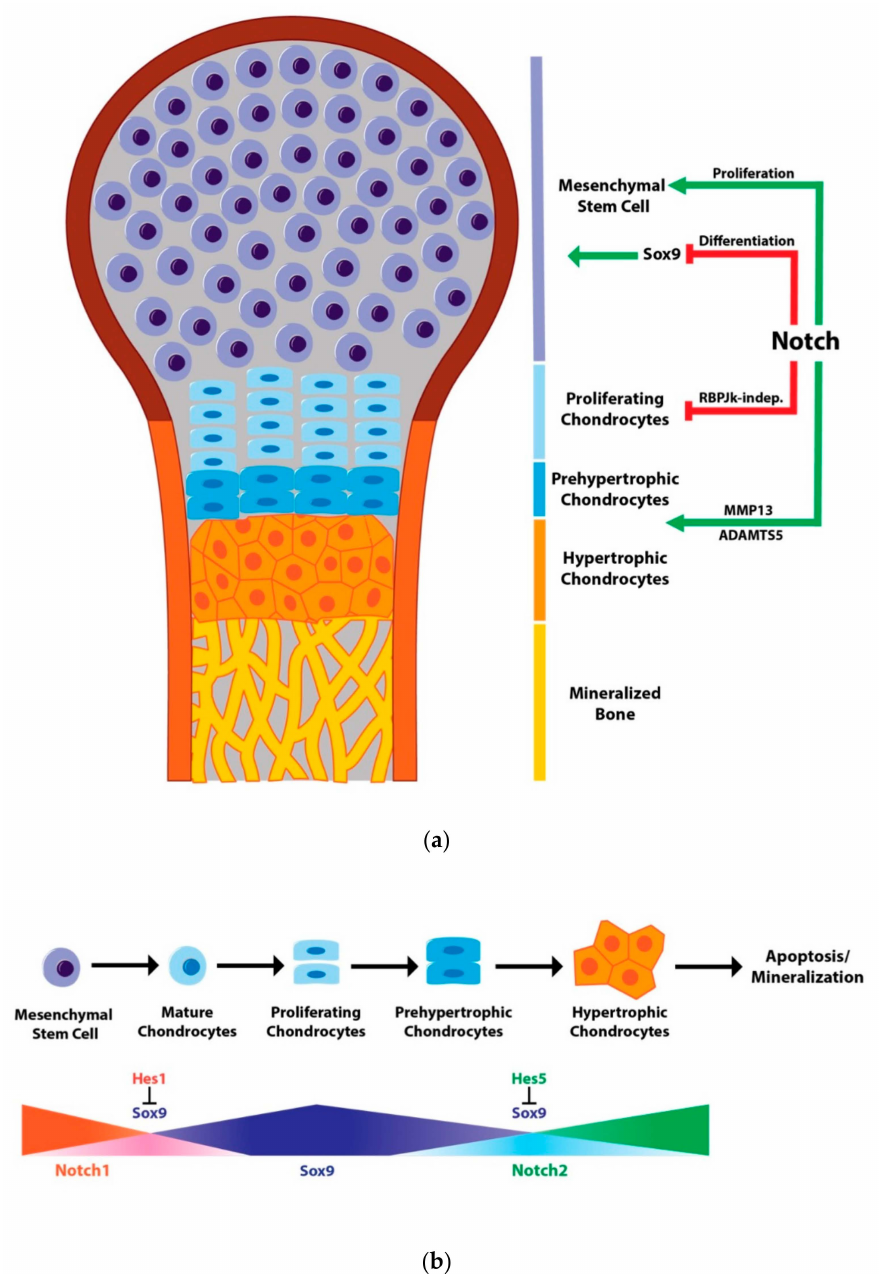
Figure 1. Notch signaling in chondrogenesis. ( a ) Notch signaling in growth plate development. Notch signaling maintains the mesenchymal cell population and functions to inhibit chondrogenesis through the reduction in Sox9 as well as Col2a1 and Agn transcription. As chondrocytes mature, Notch signaling promotes hypertrophy by blocking Sox9 expression while also promoting matrix catabolism through the induction of ADAMTS and MMP13 expression. Notch signaling also regulates chondrocyte proliferation and growth plate organization in a non-cell autonomous manner through its expression in the developing perichondrium. This regulation has been shown to occur independently of RBPjk; ( b ) Notch signaling in chondrocyte maturation. Notch1 expression is highest in mesenchymal progenitors and prevents chondrocyte maturation by inducing Hes1 expression that in turn blocks Sox9 and Col2 transcription. Sox9 levels increase as chondrocytes mature and proliferate during growth plate maturation. This increase is then reduced by Notch2 and Hes5, allowing proliferating chondrocytes to undergo hypertrophy and eventually